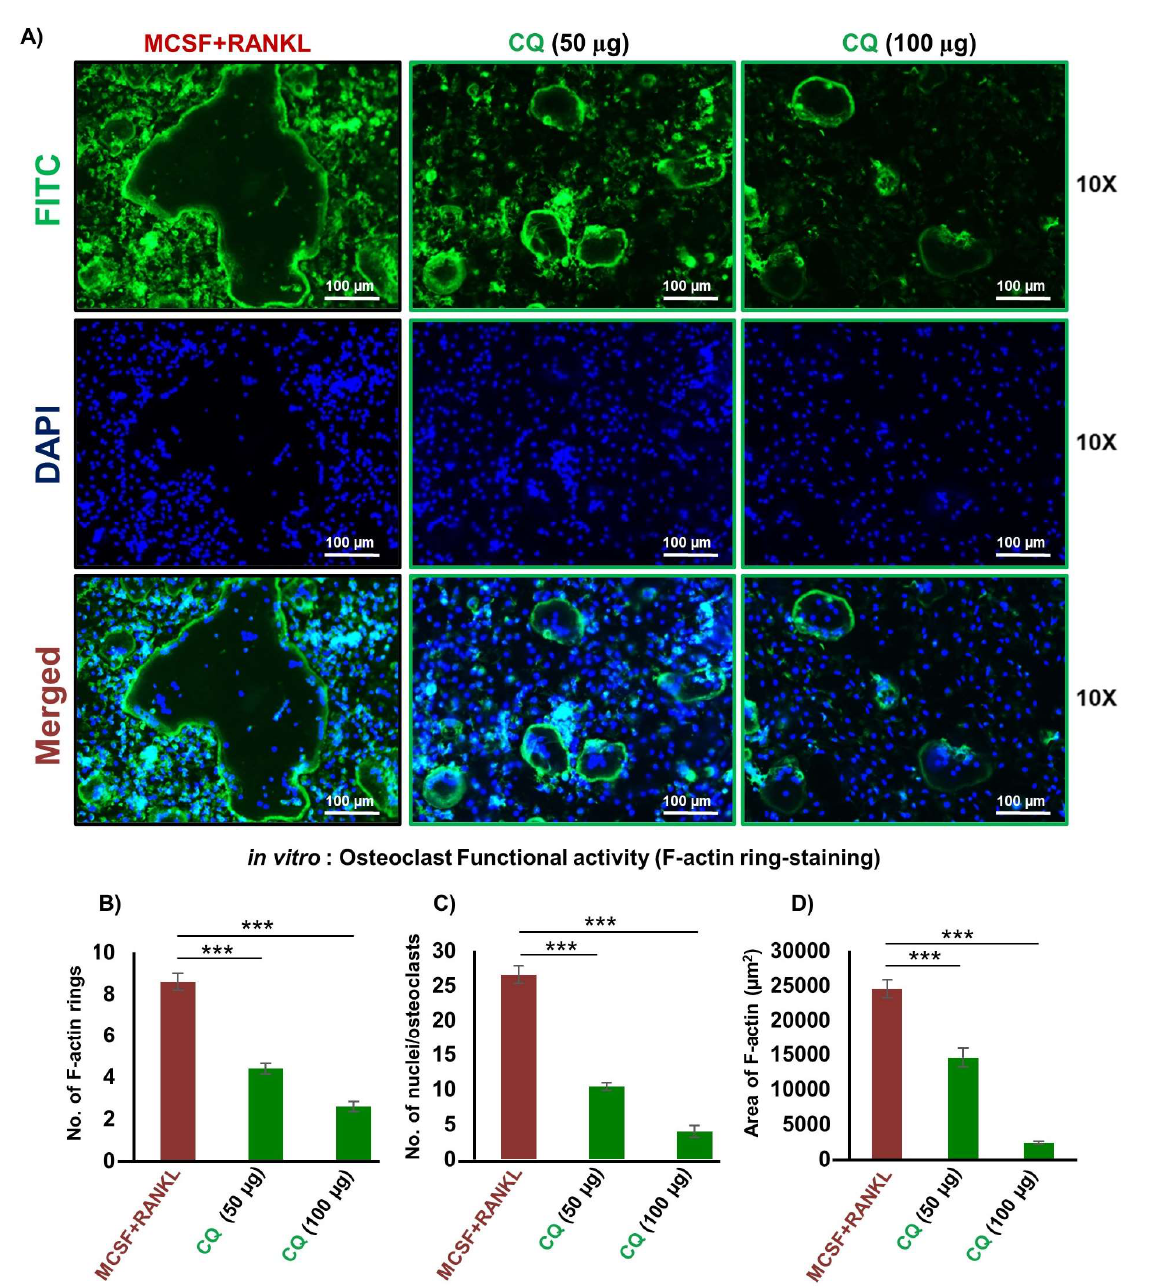
Figure 2. CQ inhibits the functional activity of osteoclasts: ( A ) FITC-conjugated phalloidin and DAPI were used to stain F-Actin and the nuclei, respectively. At a 10X magnification, images were taken using a fluorescent microscope (Imager.Z2 Zeiss microscope). ( B ) Number of F-actin rings. ( C ) Number of nuclei per osteoclast. ( D ) Area of F-actin rings. ANOVA was used to analyse the results, and then unpaired Student t-tests were used to compare the indicated groups. Values are